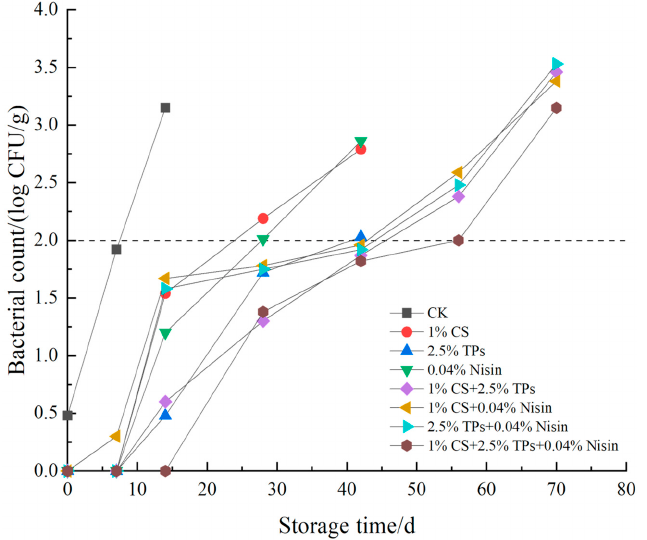
Figure 8. Effects of compound preservatives on E. coli of plant-based meat. CFU, colony-forming units; CS, chitosan; TP, tea polyphenols; CK, control group.